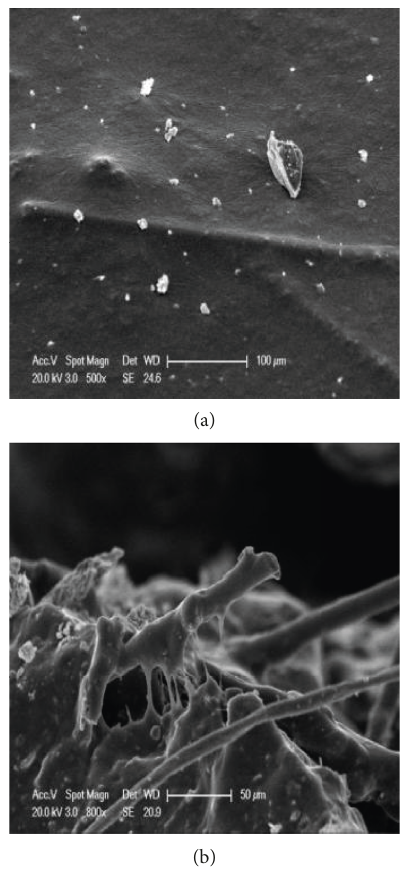
Figure 18: SEM micrographs of bonding interface between the fiber and asphalt. (a) Asphalt wrapped with chopped basalt fiber; (b) distribution of fibers in